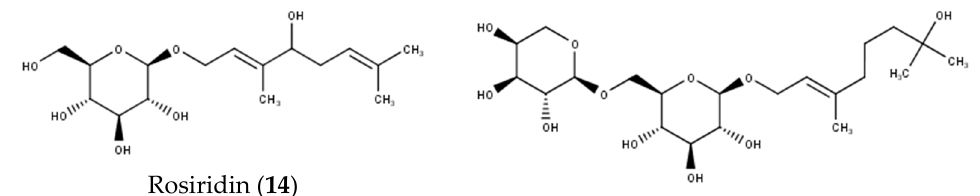
Figure 5. Structures of proposed monoterpene alcohols ( 10 , 14 ).